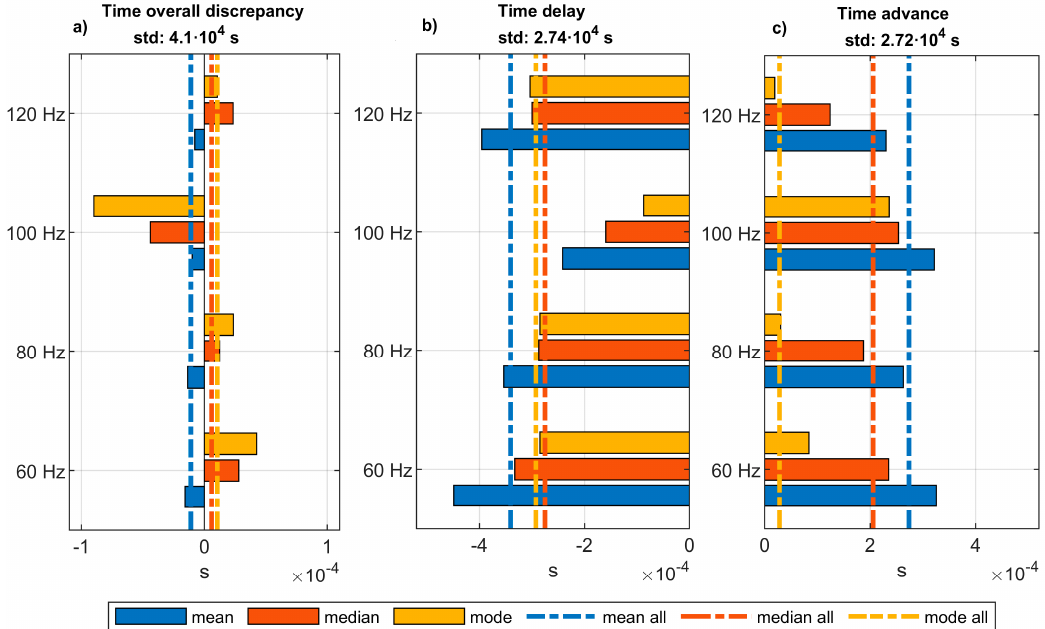
Figure 15. Mean, median, and mode of the time errors. Bar diagrams represent these statistics for the probability density functions obtained by fitting to kernel distributions the data from the experiments at different frequencies. Dashed lines represent the values of the statistics for the global distribution including the data coming from all the experiments at the different frequencies. ( a ): Presents the overall discrepancy in time, for which both positive and negative time differences are considered. ( b ): Presents the negative time differences (time delay). ( c ): Presents the positive time differences (time advance).